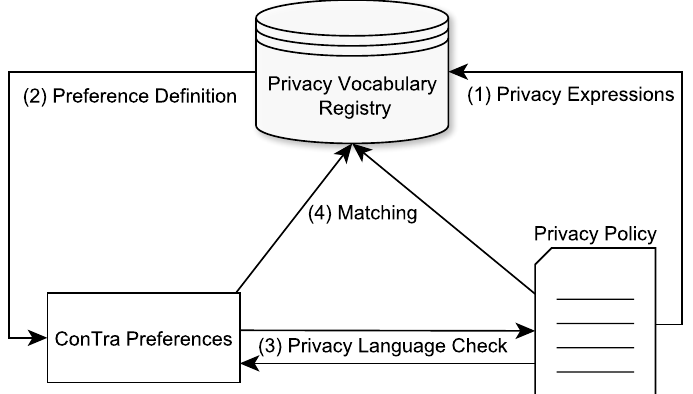
Figure 3. Workflow of the privacy interfaces process. Privacy language-specific terms and con- structs are integrated in a shared registry and later used for matching between user preferences and privacy